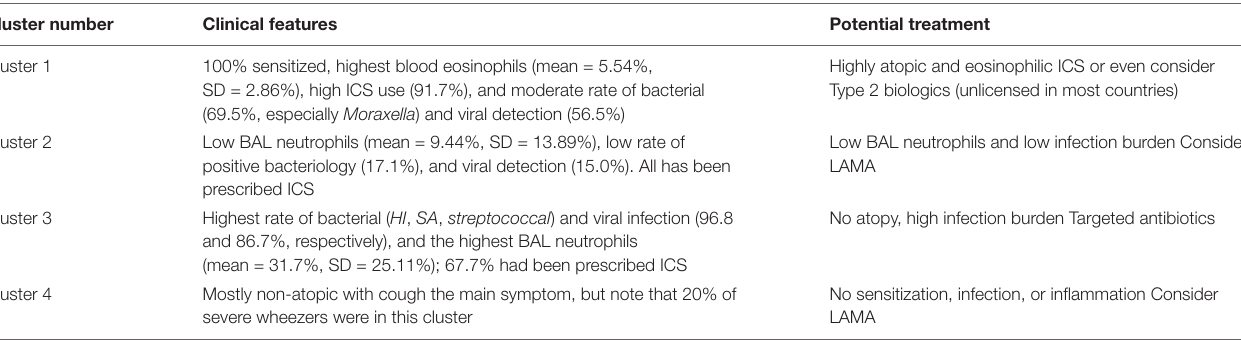
TABLE 6 | Clusters of preschool wheeze, and possible implications for treatment (85).